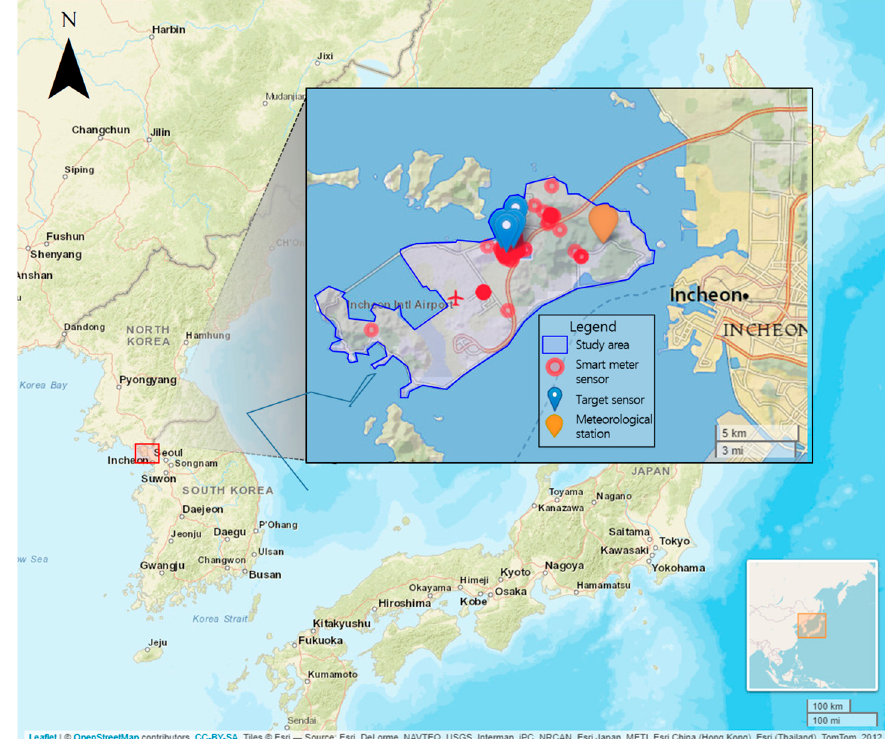
Figure 1. The location of the study area and smart water meter.